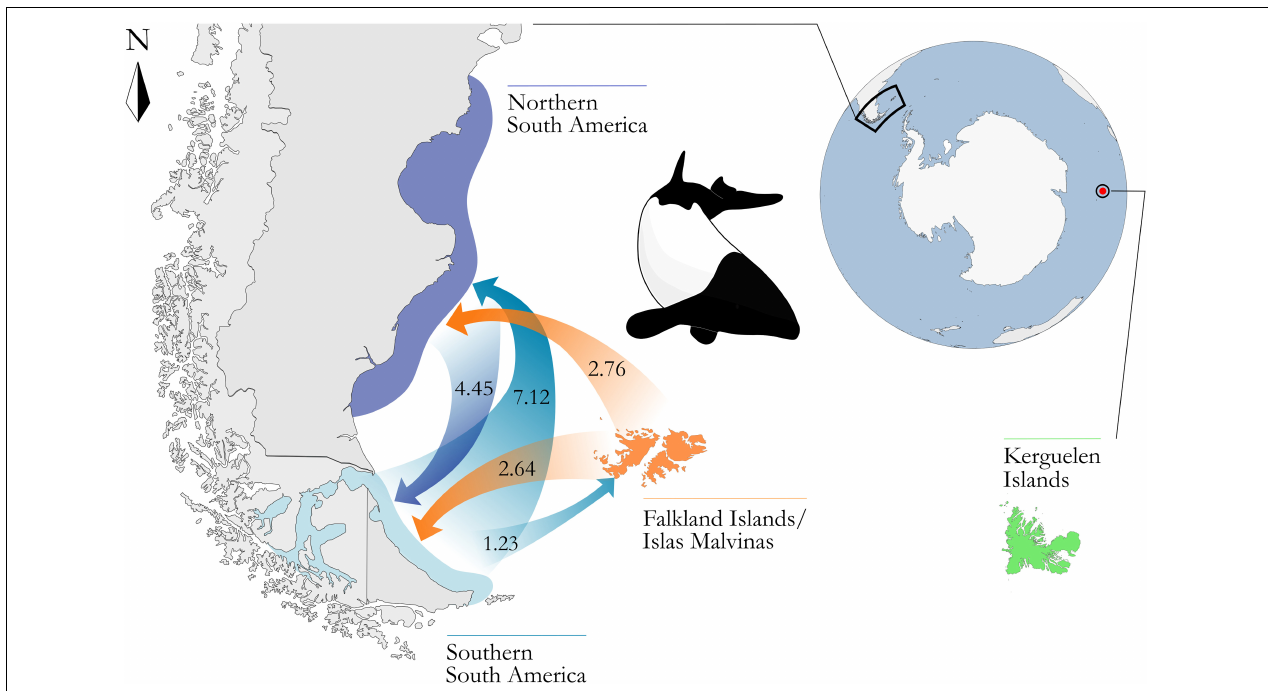
FIGURE 3 | Schematic representation of the number of effective migrants estimated in Lamarc, between the four defined regions across the distribution of the Commerson’s dolphin: northern South America (Bahía Camarones, Puerto Deseado, and Punta Quilla and Monte León), southern South America [Strait of Magellan, Fitzroy and Tierra del Fuego (A3)], Falkland Islands/Islas Malvinas, and Kerguelen Islands. Only values greater than one effective migrant per generation are shown with arrows, representing continuous historical migration between these areas. Distance between South America and Kerguelen Islands is not to scale. Map adapted from FreeVectorMaps.com